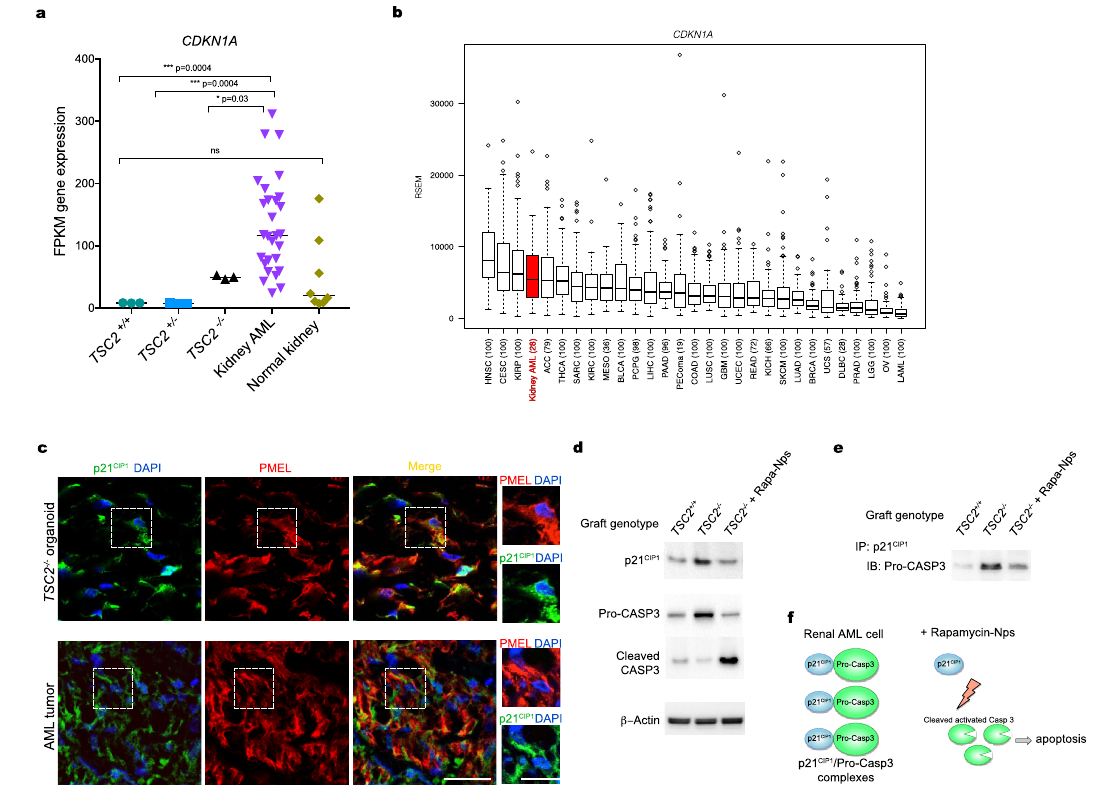
Fig. 7 Rapamycin-Nps disrupt the interaction between p21 CIP1 and pro-CASP3 in TSC2 − / − organoid AML cells in vivo. a RNAseq data box plots showing expression levels of CDKN1A in TSC2 − / − , TSC2 + / − and TSC2 + / + renal organoids ( n = 3 each, fi ve organoids per ample), compared to human kidney AML ( n = 28) and human kidney ( n = 8) samples. P values for individual comparisons done using a two-sided Mann – Whitney U test are indicated. Gene expression is shown in FPKM values. b Box-and-whisker plot showing minimum value, fi rst quartile, median, third quartile and maximum value for expression of CDKN1A in various tumors using The Cancer Genome Atlas data. Kidney AML is highlighted in red. Sample size for each type of tumor: HNSC n = 100, CESC n = 100, KIRP n = 100, kidney AML n = 28, ACC n = 79, THCA n = 100, SARC n = 100, KIRC n = 100, MESO n = 36, BLCA n = 100, PCPG n = 98, LIHC n = 100, PAAD n = 96, PEComa (19), COAD n = 100, LUSC n = 100, GBM n = 100, UCEC n = 100, READ n = 72, KICH n = 66, SKCM n = 100, LUAD n = 100, BRCA n = 100, UCS n = 57, DLBC n = 28, PRAD n = 100, LGG n = 100, OV n = 100, LAML n = 100. c Representative immunostaining and confocal images showing PMEL and p21 CIP1 in TSC2 − / − AML organoids and in kidney AML tumor samples. High magni fi cations show cytoplasmic p21 CIP1 signal. Three independent experiments were performed with similar results. Scale bars, 25 μ m, and 12.5 μ m for high magni fi cation panels. d Representative Western Blots showing levels of p21 CIP1 , pro-CASP3 and CASP3 in transplanted TSC2 + / + and TSC2 − / − organoids. Three independent experiments were performed with similar results. e Representative immunoblots showing co-immunoprecipitated p21 CIP1 and pro-CASP3 in transplanted TSC2 + / + and in TSC2 − / − renal organoids untreated or treated with Rapa-Nps. Three independent experiments were performed with similar